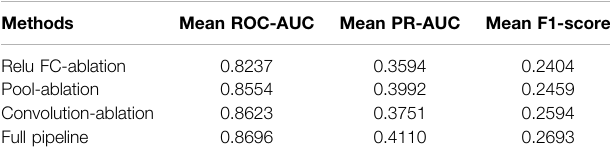
TABLE 4 | The average ROC-AUC, PR-AUC, and F1-score of the proposed model with different layer